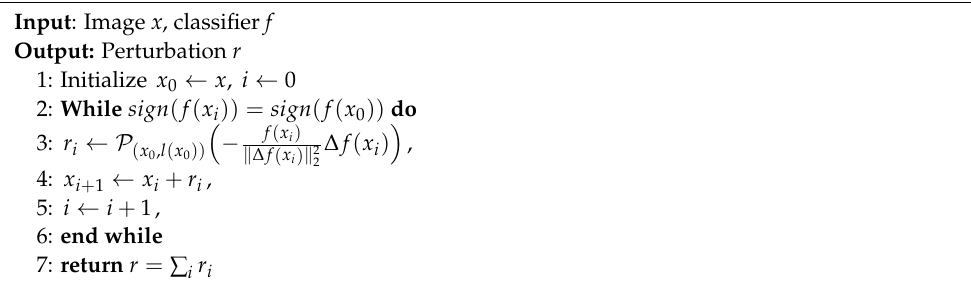
Algorithm 1 Poisson noise DeepFool (PNDF) for binary